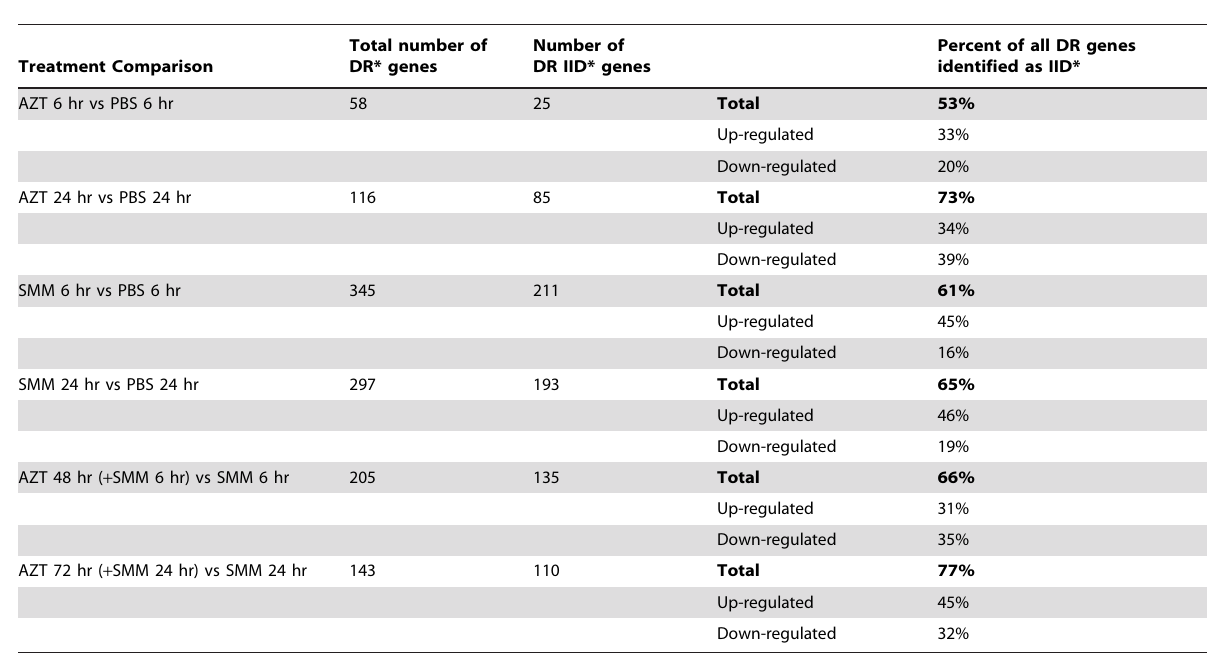
* IID=inflammatory/immune/defense related genes. DR=differentially-regulated. Genes were entered into this table as inflammation-related if the z.pv was significant ( , 0.05) and if the Gene Ontology classifications contained one or more of the following: cell adhesion, proteolysis, MAPK or MAPKKK, inflammatory/defense/immune/ acute-phase response, apoptosis/cell death, protein transport, cytokine activity, nitric oxide, NF-kappaB, antimicrobial humoral response, unfolded protein, phagocytosis, B cell activation, lymphocyte proliferation, protein transport/secretion/folding. Note: This table reflects genes, not probesets; thus, the numbers differ from Table 2. Some of the significant genes are represented by multiple significant probesets. Genes not annotated as inflammation-related are either unannotated or had Gene Ontology classifications that do not contain the annotations listed above. This table does not include differentially expressed genes in the cholesterol/fatty acid metabolic pathways or the cell cycle/mitosis/cell division pathways that are discussed in detail elsewhere in the manuscript. The table represents data from a total of 395 inflammation-related genes that were found to be differentially-regulated based upon our established criteria.